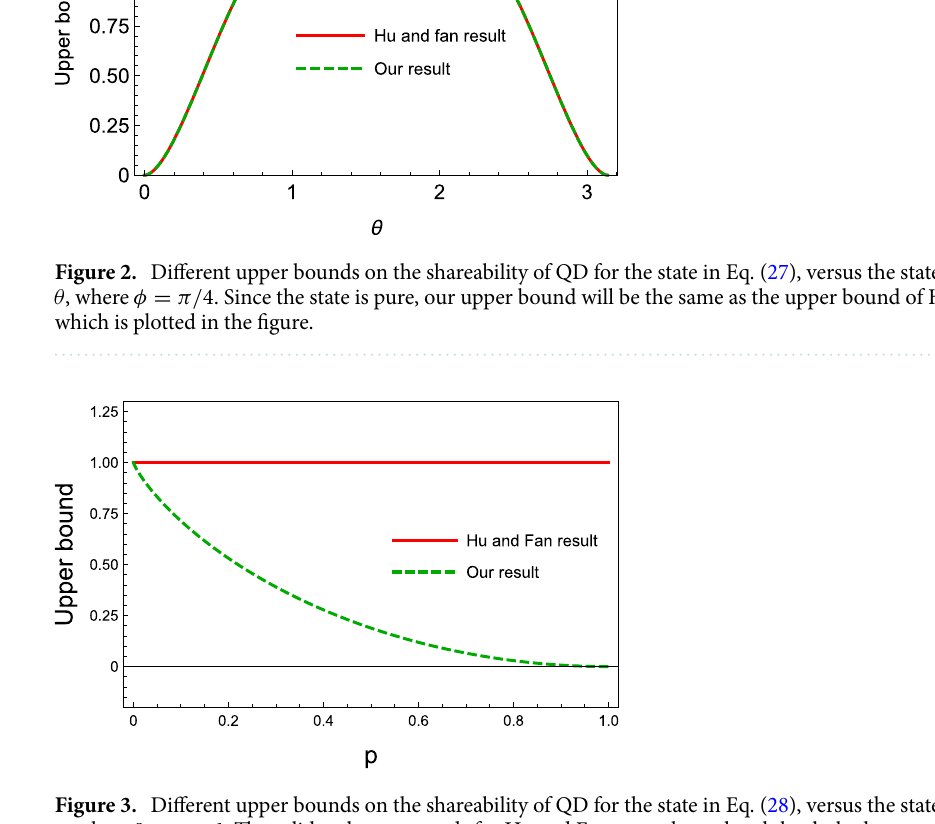
Figure 3. Different upper bounds on the shareability of QD for the state in Eq. (28), versus the state’s parameter 1 . The solid-red curve stands for Hu and Fan upper bound and the dashed-green curve p p , where 0 ≤ ≤ 0 , the state is pure, and our bound coincides with Hu and Fan upper bound; indicates our upper bound. At p = as it was expected for a pure state. It is realized that for 0 < p < 1 , our upper bound is tighter than that of Hu 1 it reaches zero which shows that at this point there is no quantum and Fan, and for p =